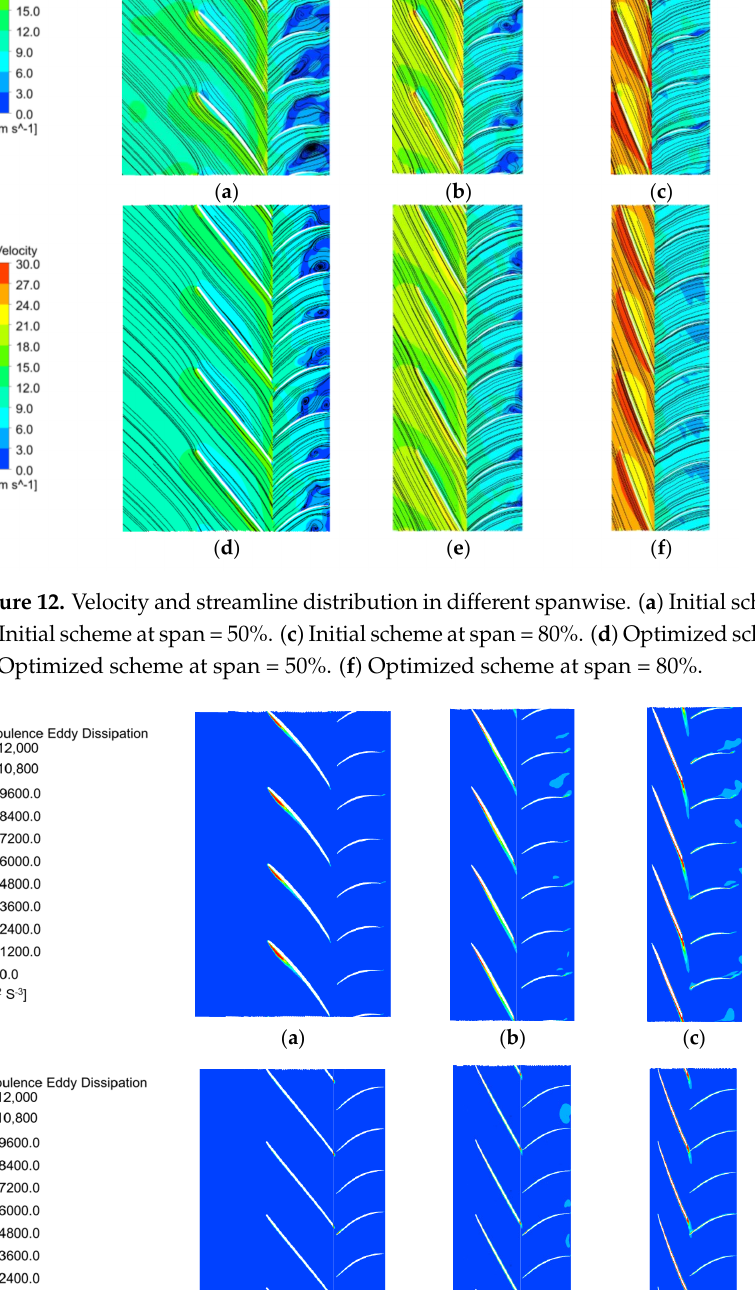
Figure 13. Turbulence eddy dissipation in different spanwise. ( a ) Initial scheme at span = 20%. ( b ) Initial scheme at span = 50%. ( c ) Initial scheme at span = 80%. ( d ) Optimized scheme at span = 20%. ( e ) Optimized scheme at span = 50%. ( f ) Optimized scheme at span = 80%.